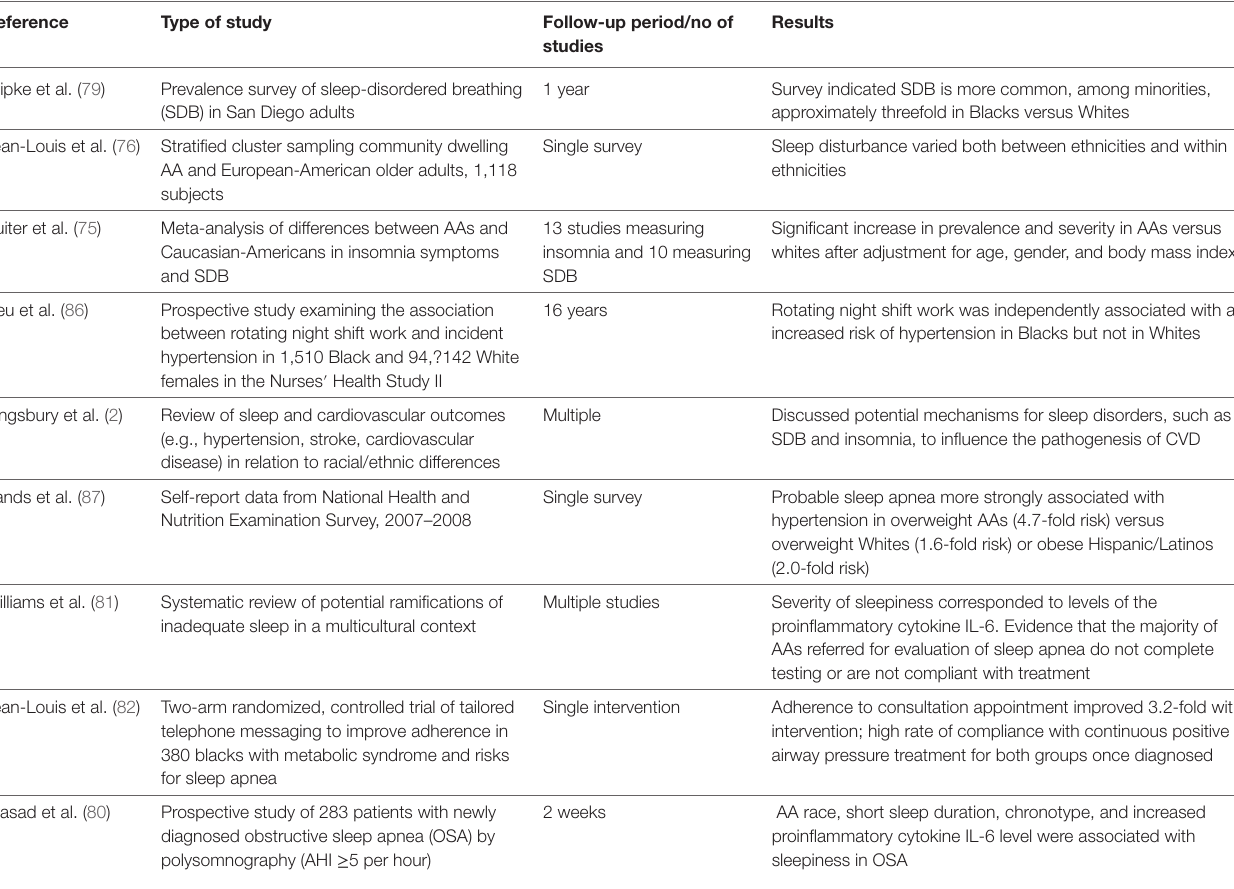
TAbLe 2 | Summary of studies examining association between sleep disorders and cardiometabolic diseases in African-Americans (AAs). Reference